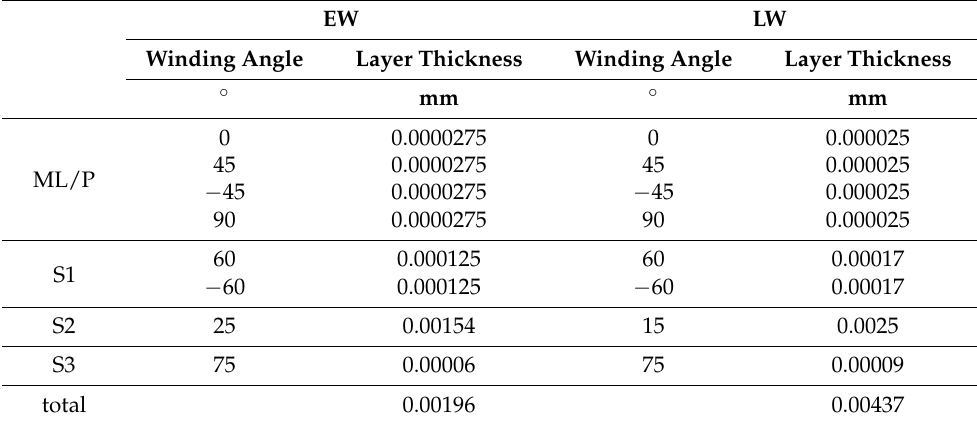
Figure 4. Dimensions in mm of EW ( a ) and LW ( b ) tracheid CAD model. To estimate the density of the tracheids, their cross-sectional areas of cell wall and lumen were set in relation to each other. The results (EW 0.251 g/cm 3 and LW 0.802 g/cm 3 ) correlate with other research [20]. Table 4 displays the laminate setup chosen to replicate the single layers of the tracheid cell wall based on the research values cited above (Table 2). A quasi-isotropic layer structure with 0/45/ − 45/90 ◦ orientation was selected for the ML/P layer, and the layer thickness was quartered accordingly. The S1 layer was constructed in a two-ply structure with a winding angle of 60 and − 60 ◦ . The S2 layer was built up for EW at 25 ◦ and for LW at a 15 ◦ winding angle. The resulting total thickness of both laminate structures corresponds to the research values from Table 2. Table 4. Number of layers, layer thickness and winding angle used for tracheid